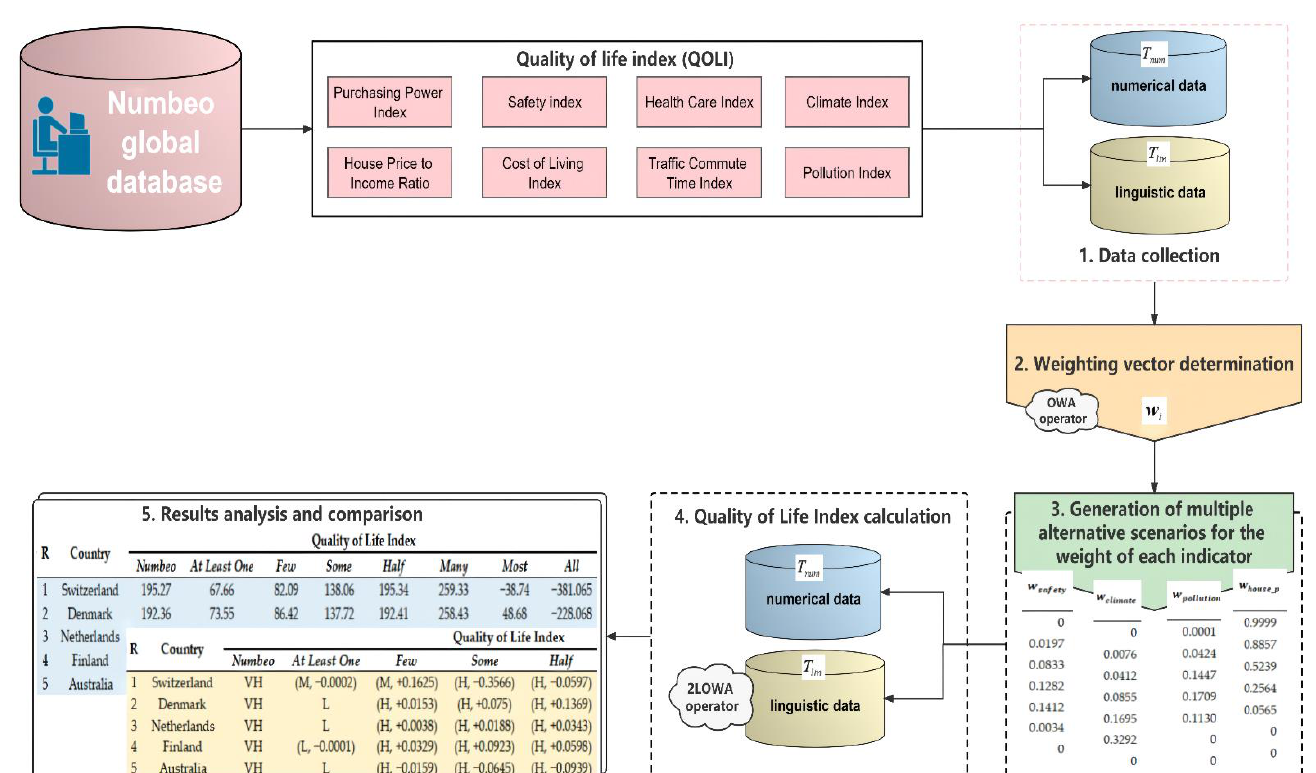
Figure 4. Steps of the 2LOWA – QOLI model.